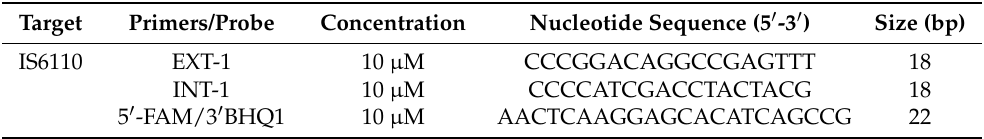
Table 2. Primers and probes used for real-time PCR